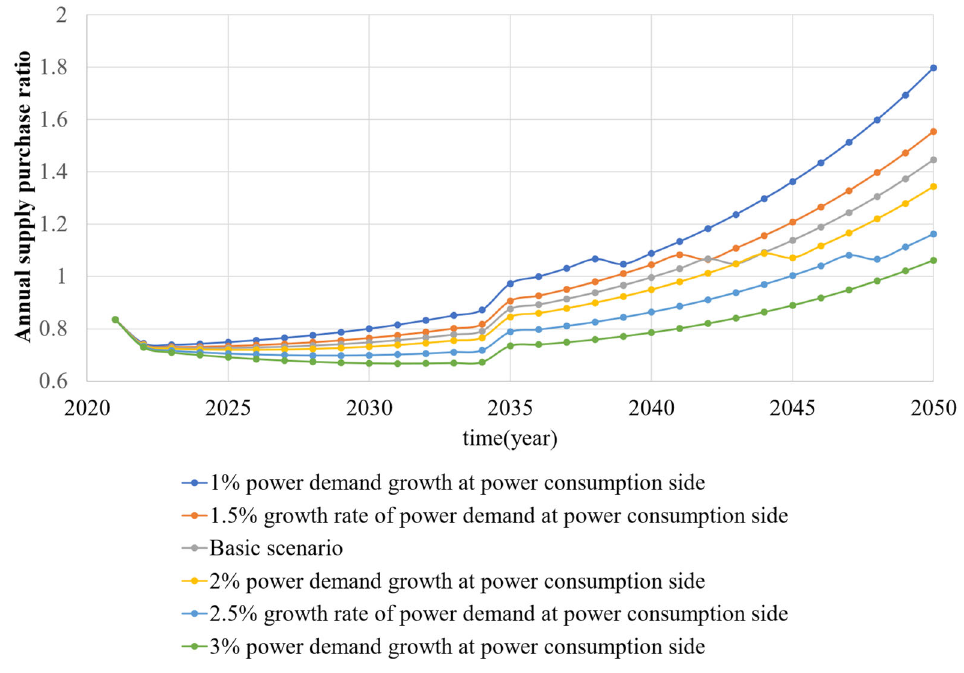
Figure 16. Change in annual supply–purchase ratio based on the growth rate of electricity demand at the consumption side.